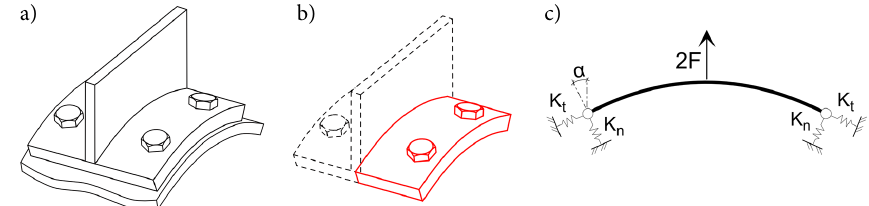
Figure 1. Simplification of the T-stub: a – curved T-stub; b – arched-beam; c – arch on spring